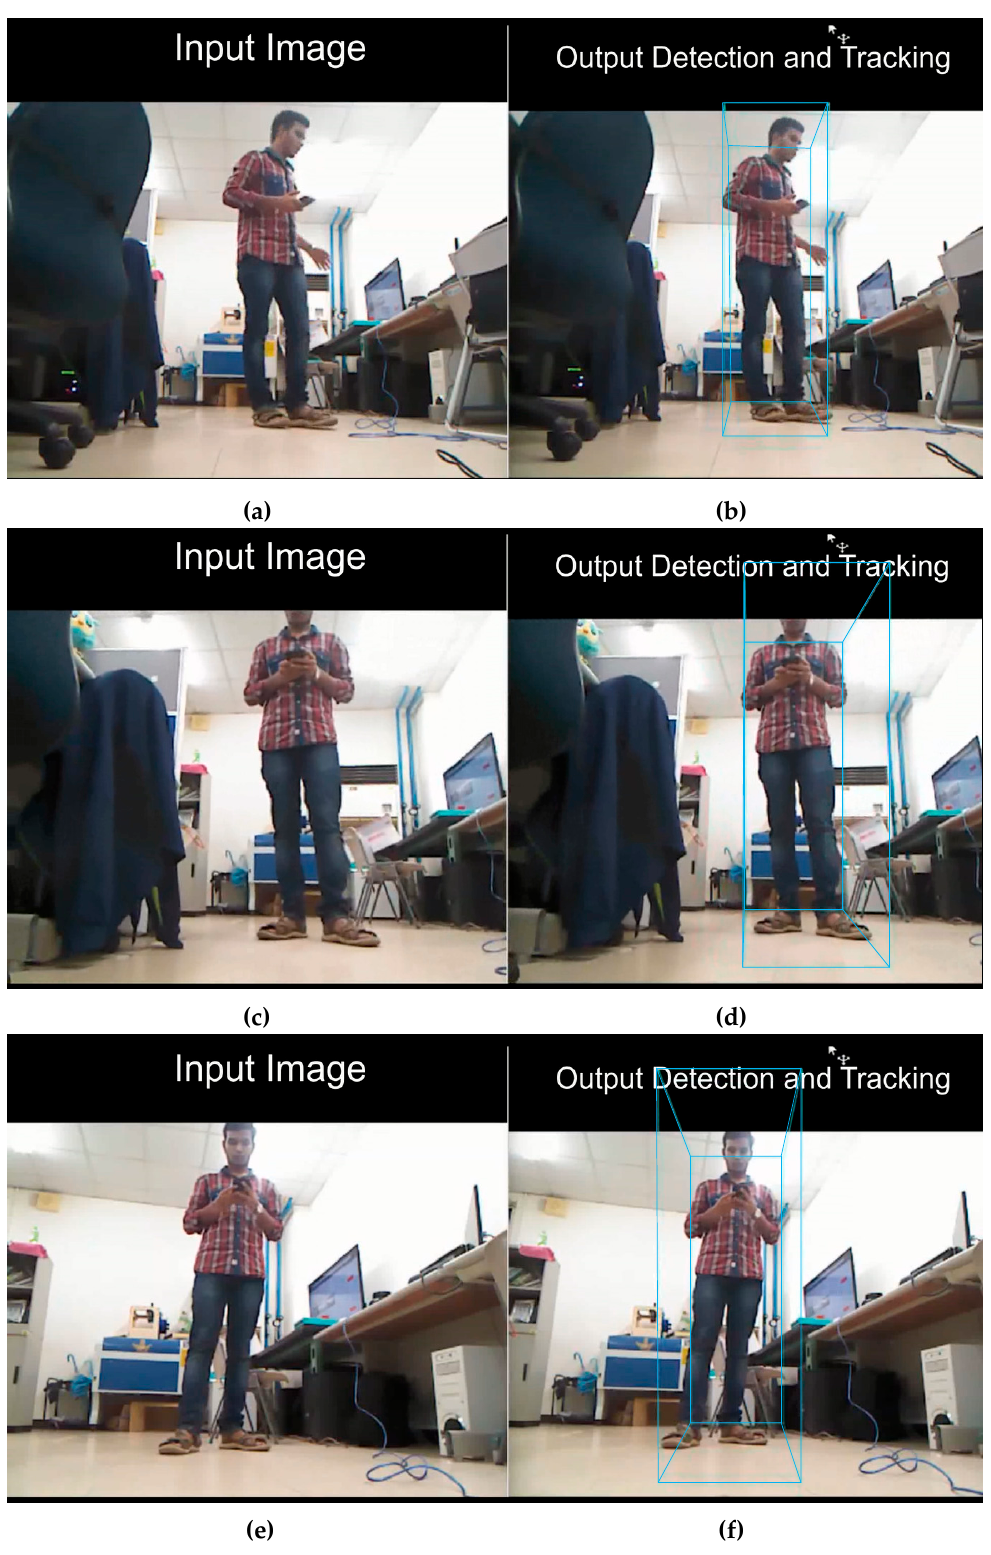
Figure 8. Recorded image sequence of interaction between one human and the mobile robot through wireless remote control.